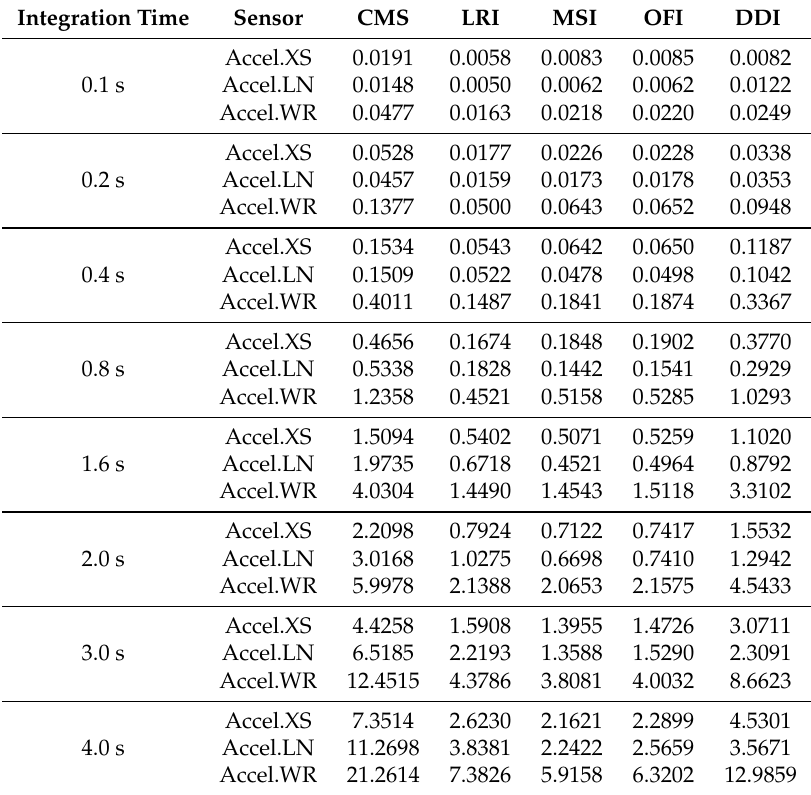
Table A1. RMS position error growth (in mm) with integration time.